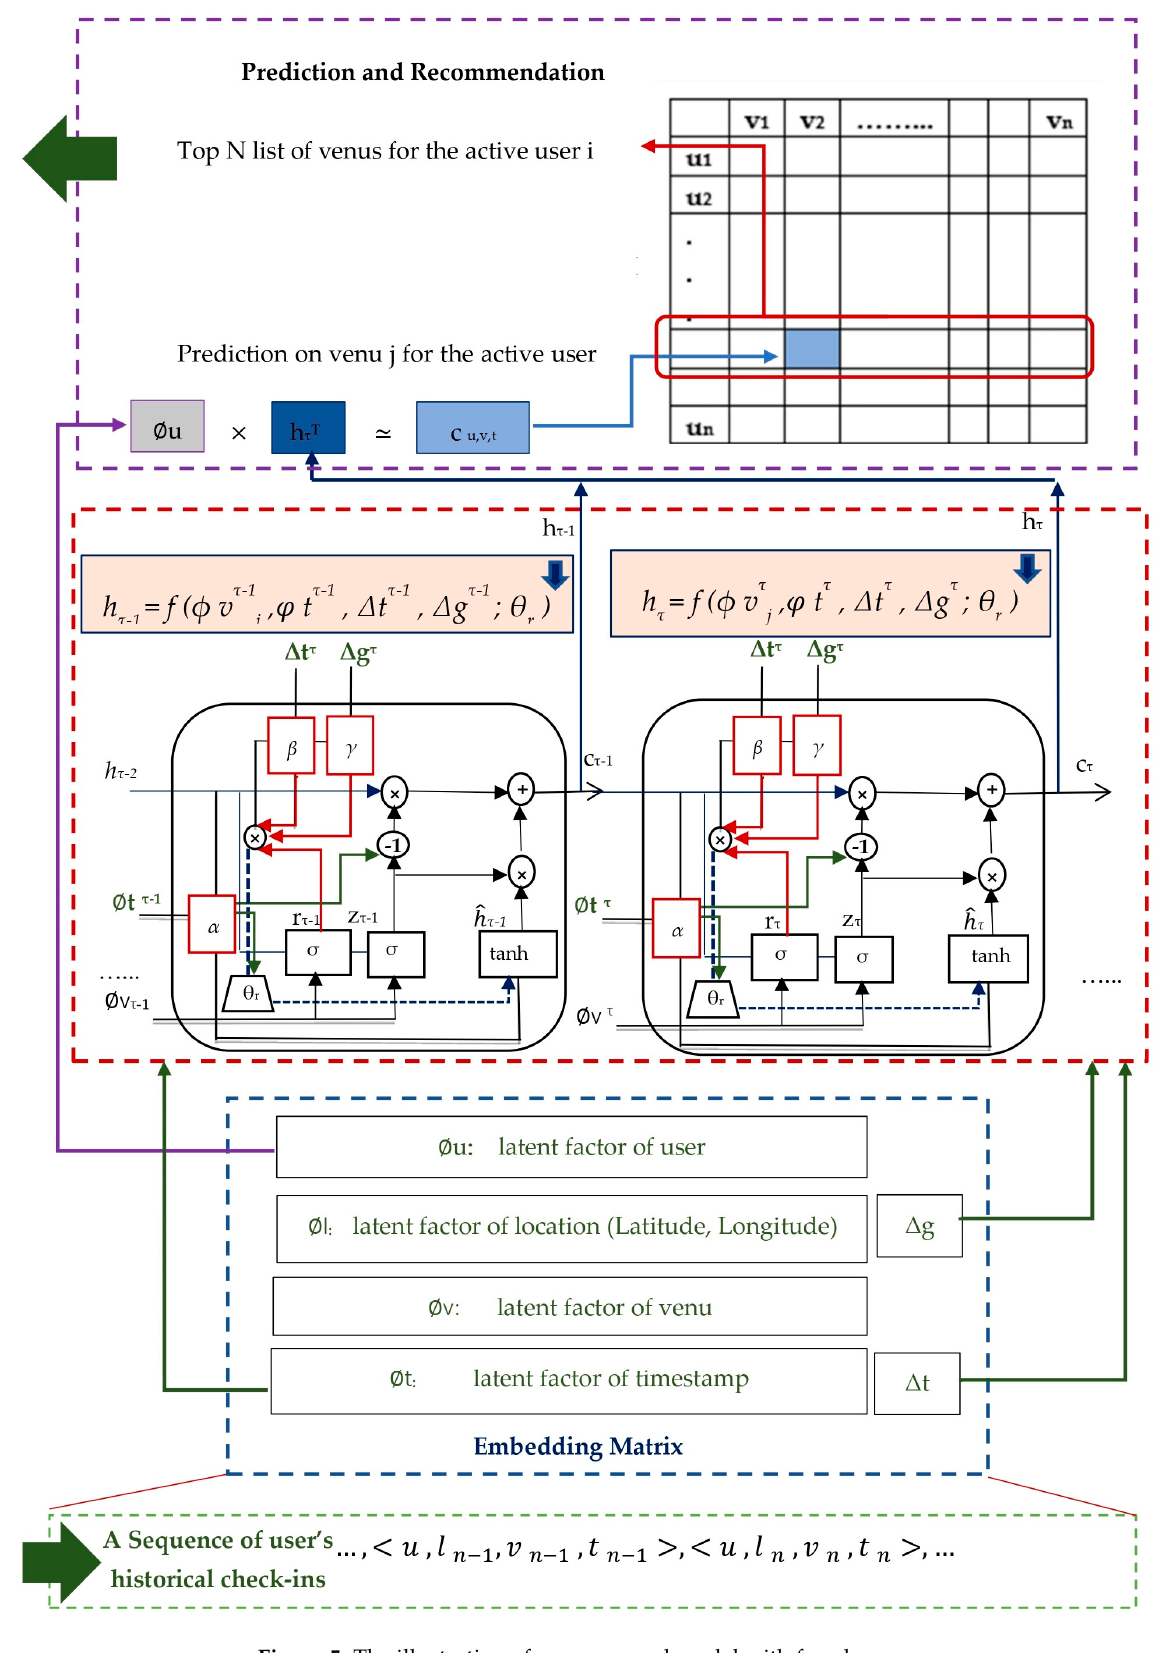
Figure 5. The illustration of our proposed model with four layers.